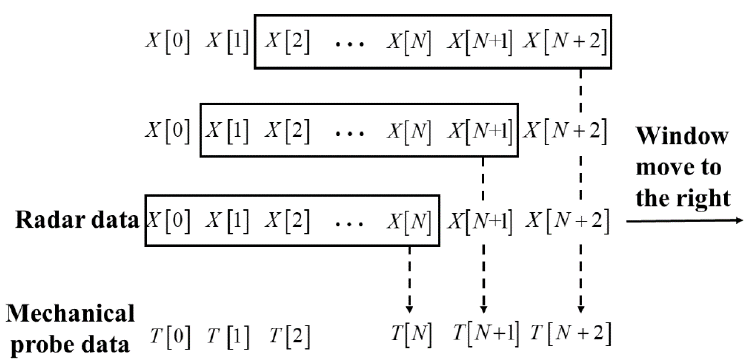
Figure 3. Schematic of the data processing process of the sliding window.